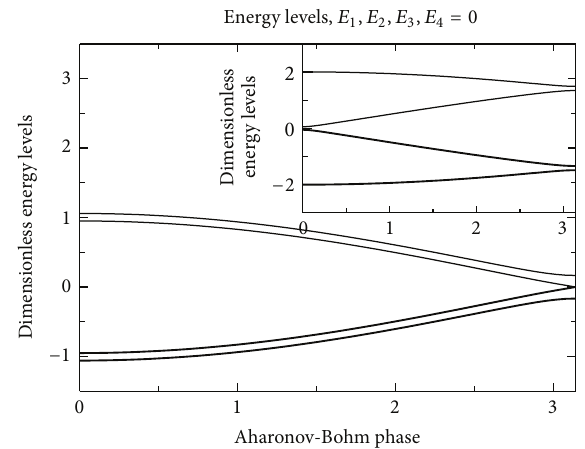
Figure 14: (Main) Variation with the magnetic Aharonov-Bohm phase 𝜙 of the energy spectrum (units 𝐷 2 = 1 ) for the case 𝐷 1 = 0 and a choice of 𝐸 1 , 𝐸 2 , 𝐸 3 , 𝐸 4 with √𝐸 2 1 + 𝐸 2 2 + 𝐸 2 3 + 𝐸 2 4 /𝐷 2 = 0.01 . This is to be compared with the 3LS energy spectrum, Figure 5. (Inset) The energy spectrum in the opposite case, 𝐷 2 = 0 , and a choice of 𝐸 1 , 𝐸 2 , 𝐸 3 , 𝐸 4 with 𝐷 1 about 100 times